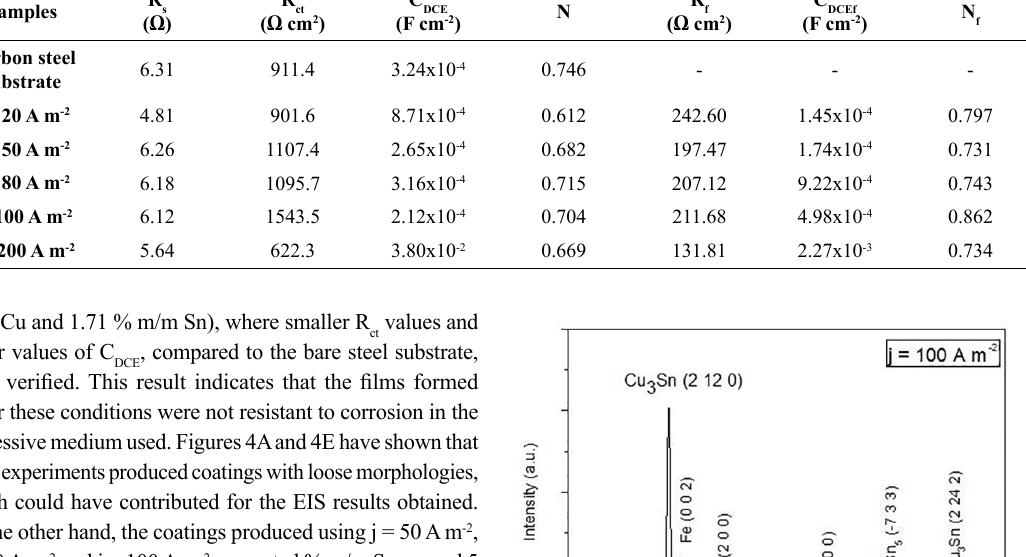
and CDCE values obtained from the simulation of the EIS data for carbon steel and Cu-Sn coatings in NaCl 0.5 mol L -1 . Table 2. R ct Samples